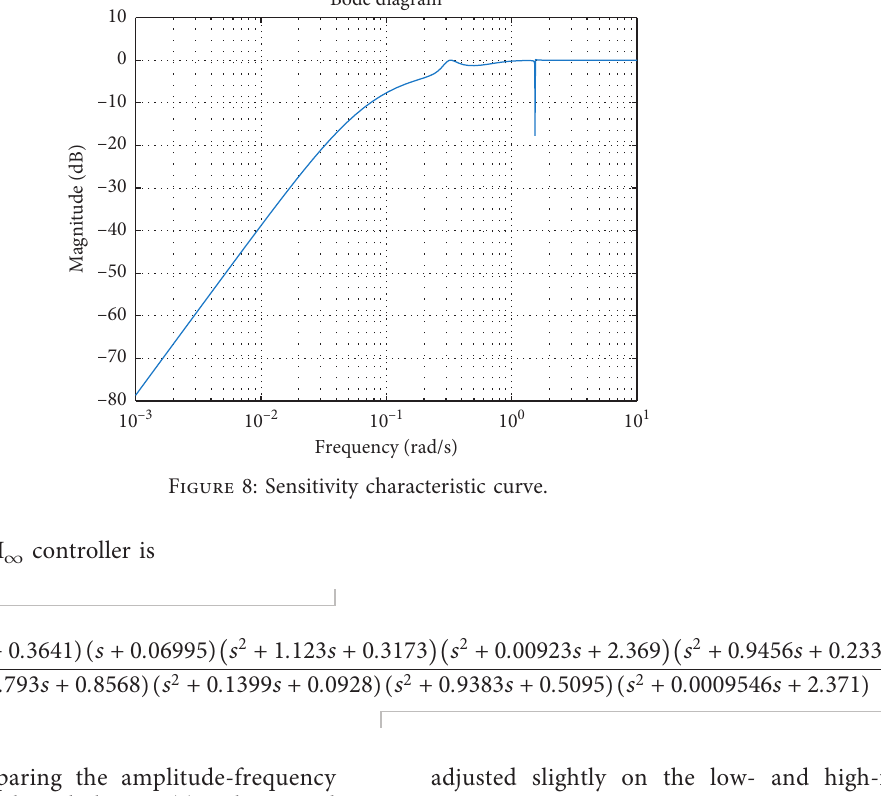
, (b) G s ( S ) and the transfer function. ∞